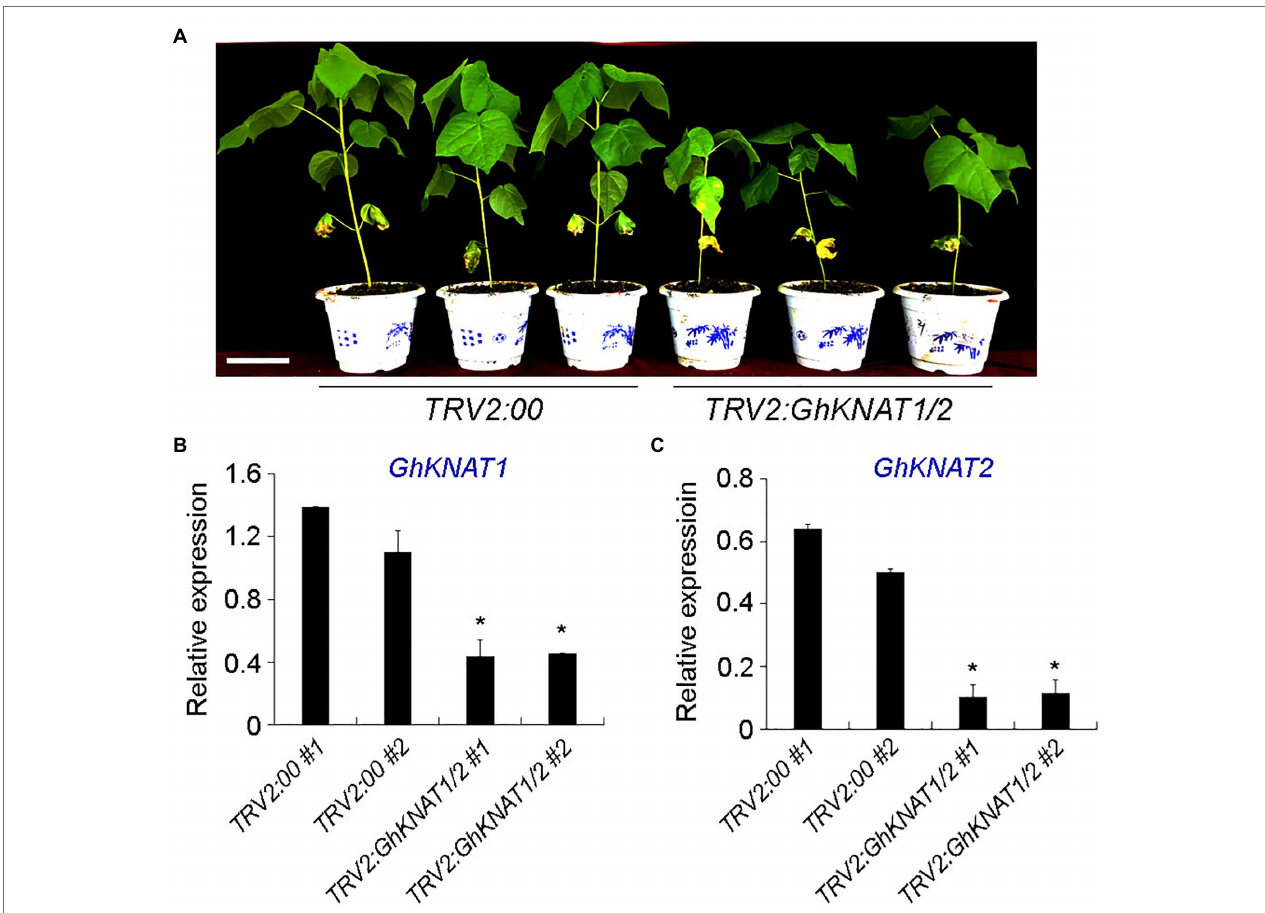
FIGURE 8 | Phenotypic analyses of TRV2:GhKNAT1/2 plants. (A) Plant height comparison of 5–6 leaf stage TRV2:GhKNAT1/2 plants with TRV2:00 plants (negative control group). (B,C) Expression analysis of GhKNAT1 and GhKNAT2 in main stem apex of TRV2:00 (B) and TRV2:GhKNAT1/2 (C) plants, respectively. Results were normalized against the expression level of GhUBI1 . Error bars indicate SD of three biological replicates (* p <